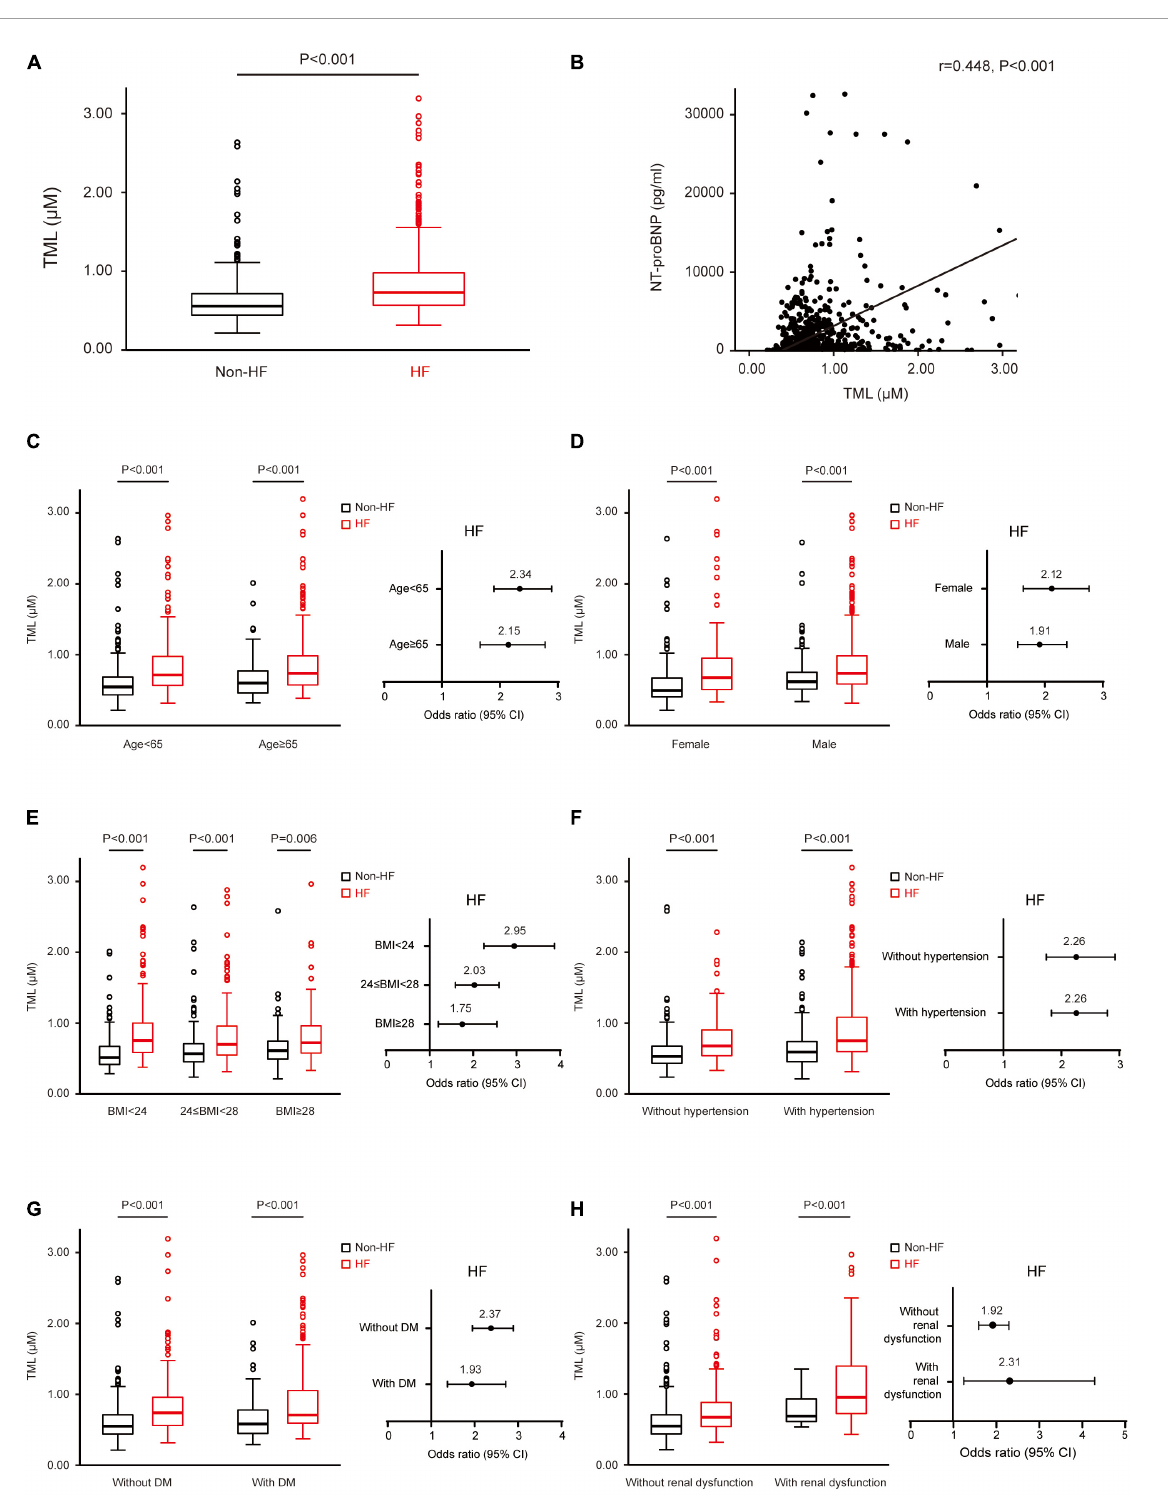
FIGURE1 Trimethyllysine (TML) levels are associated with the presence and severity of heart failure (HF) in all subjects and different subgroups. (A) TML levels are increased in patients with HF compared with the non-HF group in all subjects at baseline. (B) Simple correlation analysis between serum levels of TML and N-terminal pro-brain natriuretic peptide (NTproBNP). Box–Whisker plots of TML levels among patients with and without HF in different subgroups, including ages < 65 and ≥ 65 (C) ; male and female (D) ; normal, overweight, and obesity (E) ; with and without hypertension (F) ; with and without DM (G) ; as well as with and without dyslipidemia (H) . Forest plots illustrate the odds of the presence of HF according to TML levels in these subgroups (C–G) . Symbols represent odds ratios (ORs) and the 95% confidence intervals are shown by line